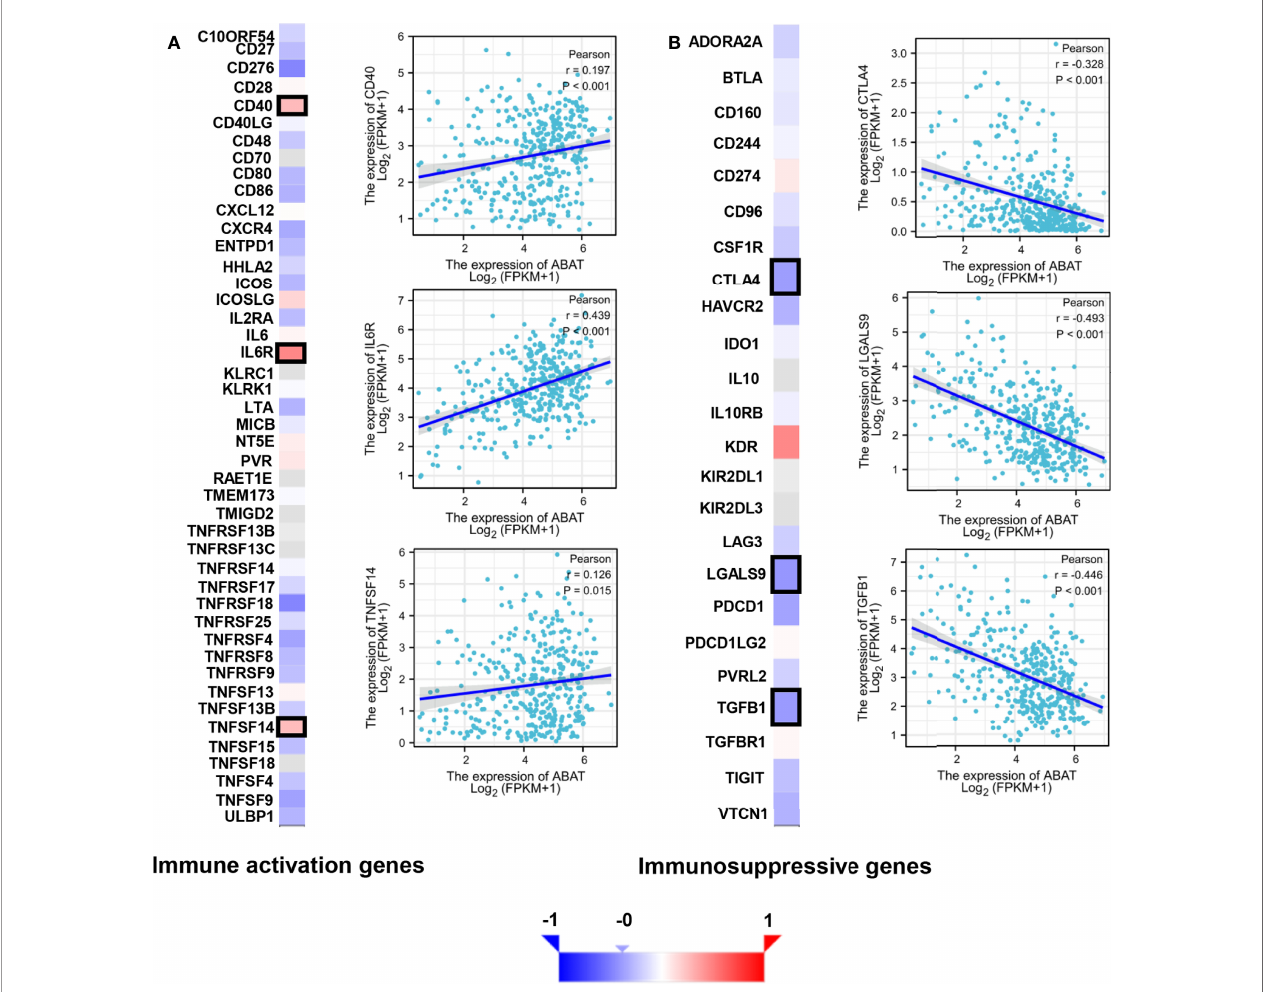
FIGURE 12 | Correlation of ABAT levels with the expression of immunomodulators in HCC. (A) The heatmap of the correlation with immune activation genes and display of three representative molecules. (B) The heatmap of the correlation with immunosuppressive genes and display of three representative molecules. The representative molecules are surrounded by black frames in the